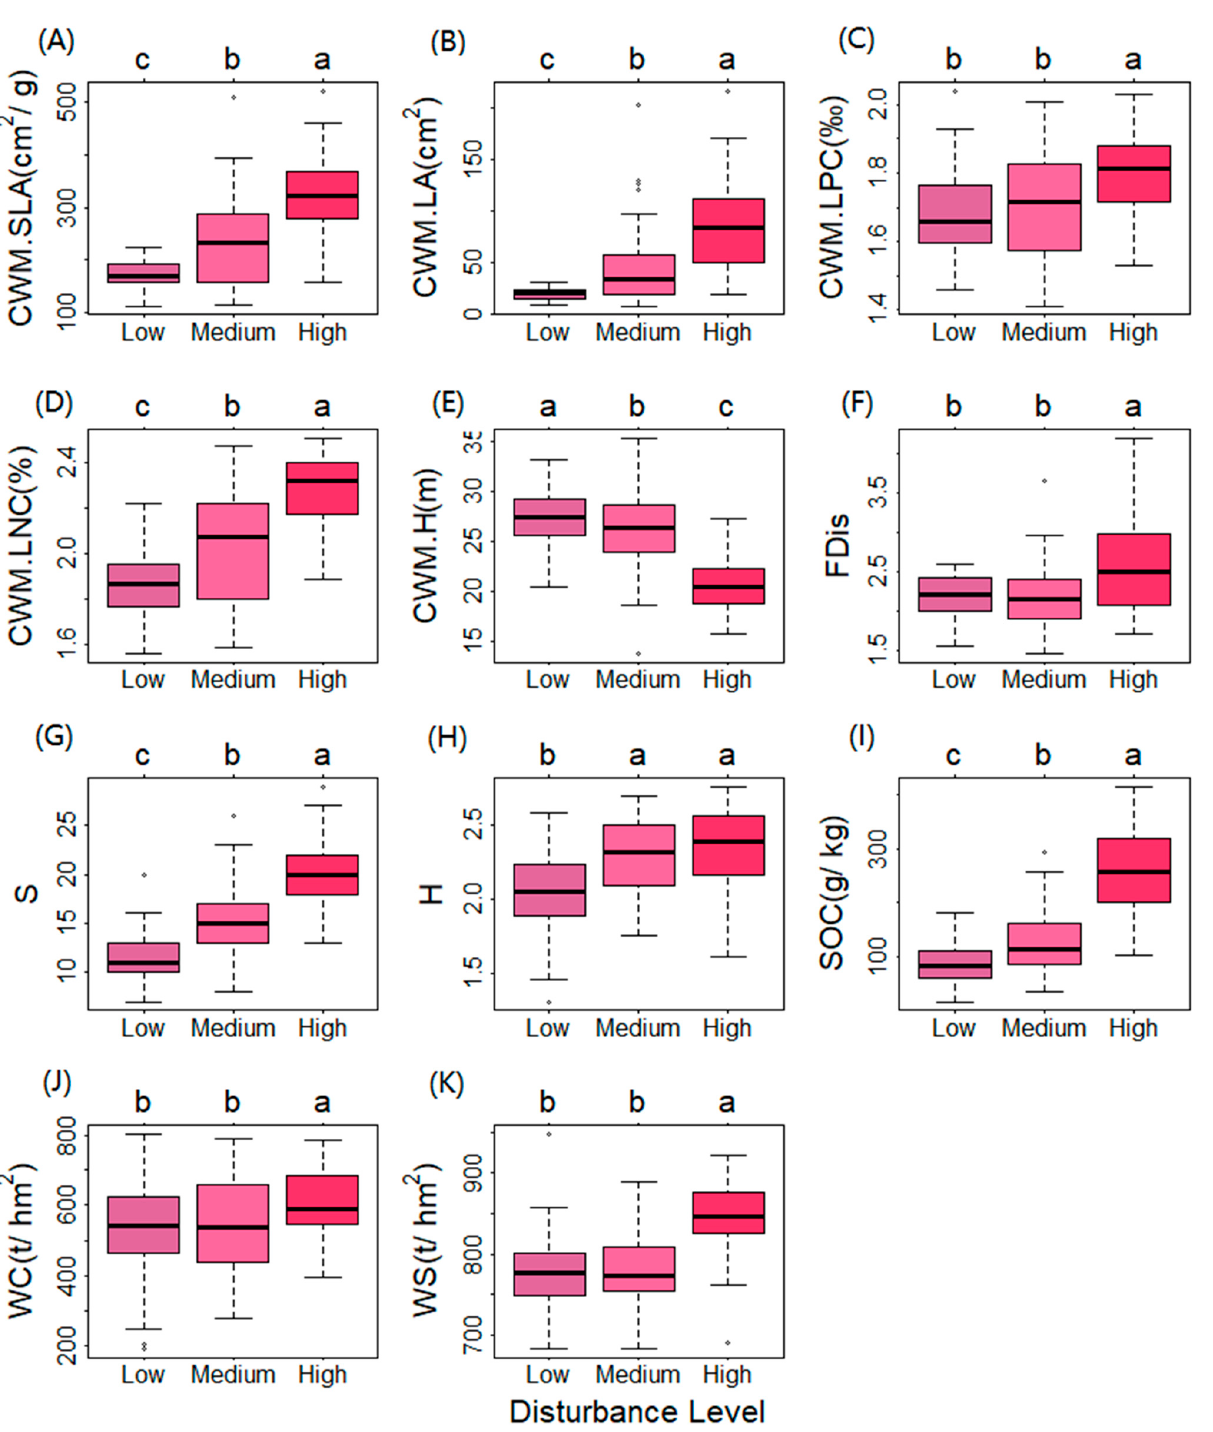
Figure 2. The influence of disturbance intensity on ( A ) community weighted mean of specific leaf area (CWM.SLA), ( B ) community weighted mean of leaf area (CWM.LA), ( C ) community weighted mean of leaf phosphorus content (CWM.LPC), ( D ) community weighted mean of leaf nitrogen content (CWM.LNC), ( E ) community weighted mean of maximum tree height (CWM.H), ( F ) tree functional dispersion diversity (FDis), ( G ) tree species richness (S), ( H ) tree Shannon diversity (H), ( I ) soil organic carbon content (SOC), ( J ) soil capillary water retention (WC), and ( K )soil saturated water retention (WS). Different letters (a–c) reflect significant (Tukey’s test, p < 0.05) differences between three different disturbance levels. Boxplots represent median, first and third quartiles, and upper hinge and lower hinge. Abbreviations are same as